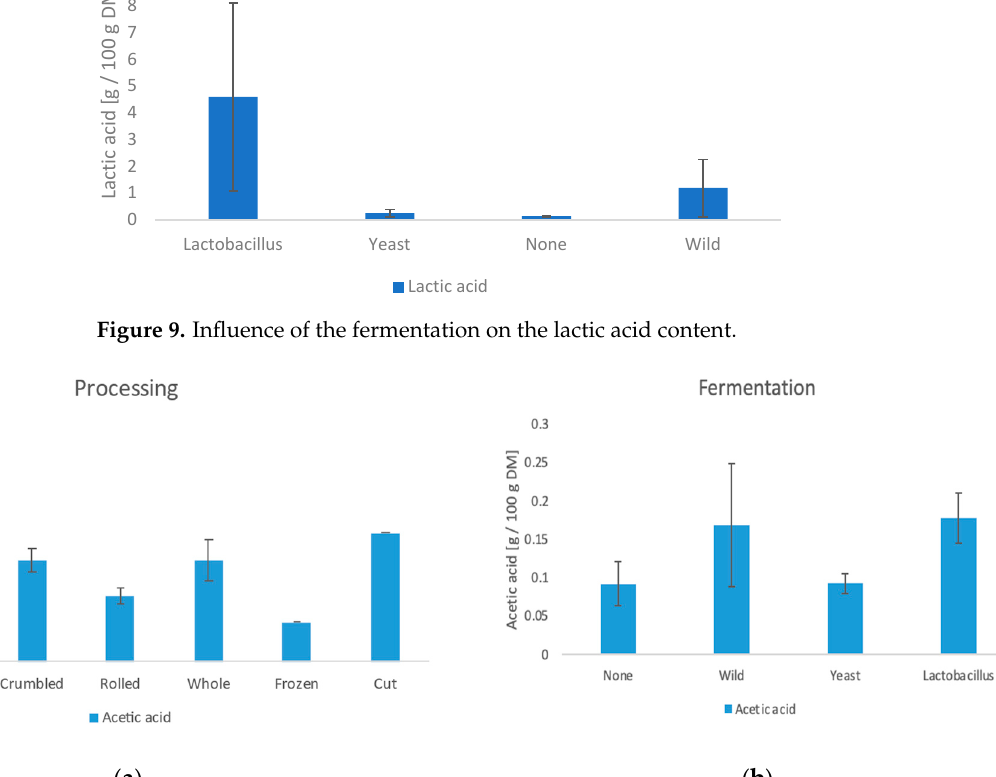
( b ) Figure 11. ( a ) Influence of the leaf type on the trigonelline content. ( b ) Influence of the drying method on the trigonelline content. 3.6.1. Chlorogenic Acid The content of chlorogenic acid (3-caffeoylquinic acid) varies between not detectable and 9.35 g/100 g DM. The significant influences here are the leaf type and the processing. The young leaves show the highest amount of chlorogenic acid with 5.33 g/100 g DM fol- lowed by shoots with 1.96 g/100 g DM, the old leaves with 1.71 g/100 g DM, and the yellow leaves with 1.21 g/100 g DM. As with caffeine, chlorogenic acid exerts a protective effect on the leaf through its antioxidant property. Therefore, here it is also present in an in- creased amount in the young leaves. These data also coincide with the analyses already carried out by Monteiro et al. [45]. Furthermore, it is shown that freezing (0.31 g/100 g DM) and blending (0.47 g/100 g DM) have a negative effect on the amount. The negative effect of freezing contradicts a study by Ś cibisz et al. [46] where freezing had no effect. 3.6.2. Lactic Acid Lactic acid varied from 0.11 g/100 g DM to 8.12 g/100 g DM in the samples. As ex- pected, the samples fermented with the Lactobacillus showed the highest value. Further- more, an increased amount is found in the wild fermented samples. This suggests that a certain percentage of lactic acid bacteria is present in the microbiota of the coffee leaf.